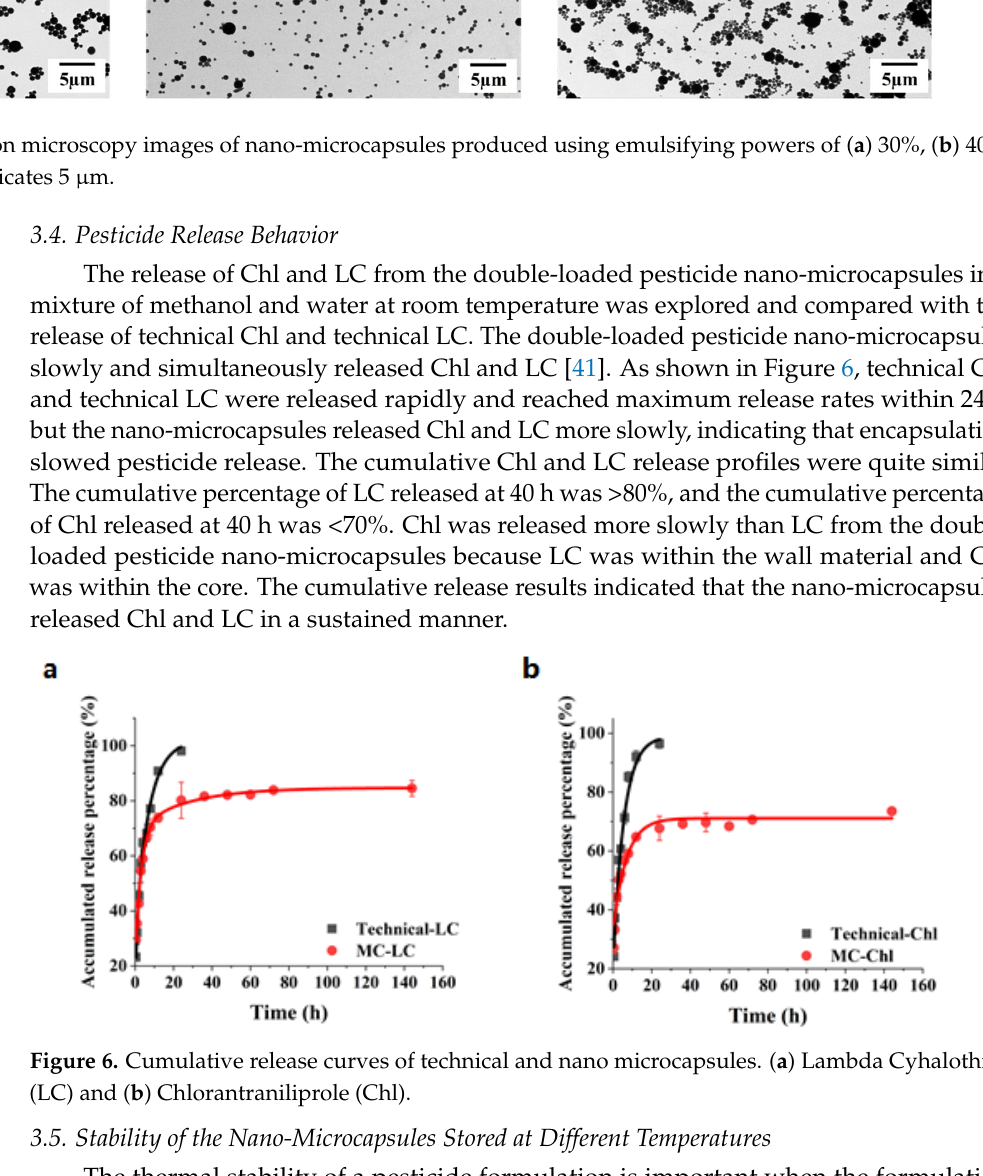
Figure 5. Transmission electron microscopy images of nano-microcapsules produced using emulsifying powers of ( a ) 30%, ( b ) 40%, and ( c ) 50%. The scale bar indicates 5 µm.